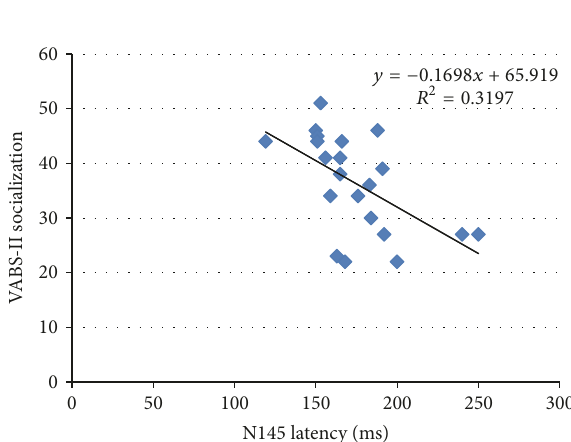
Figure 3: Scatter plot displaying the correlation between N145 latency over Oz electrode and VABS-II standard scores in the socialization